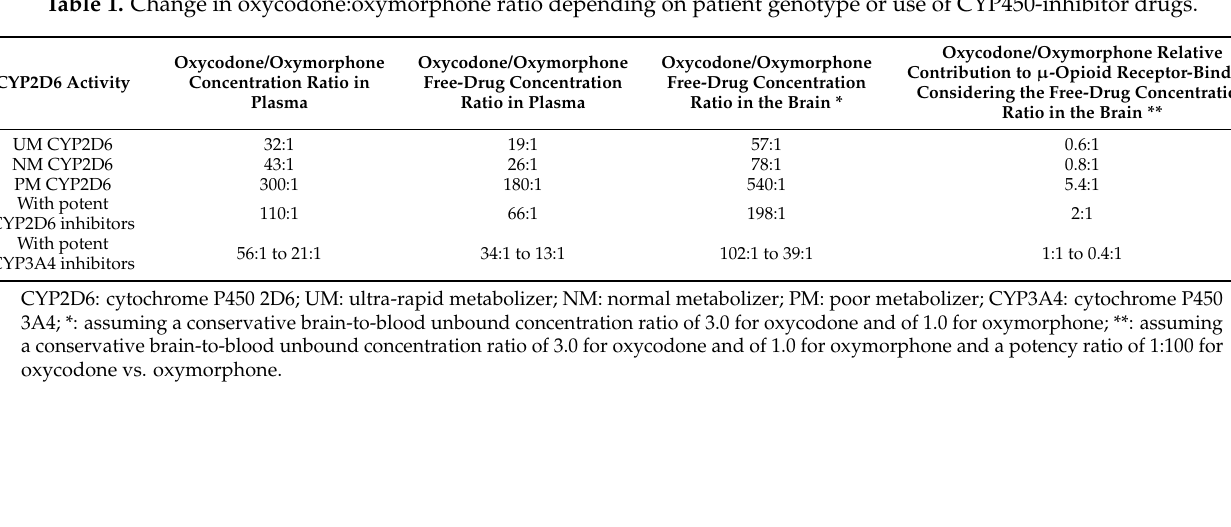
Table 1. Change in oxycodone:oxymorphone ratio depending on patient genotype or use of CYP450-inhibitor drugs.